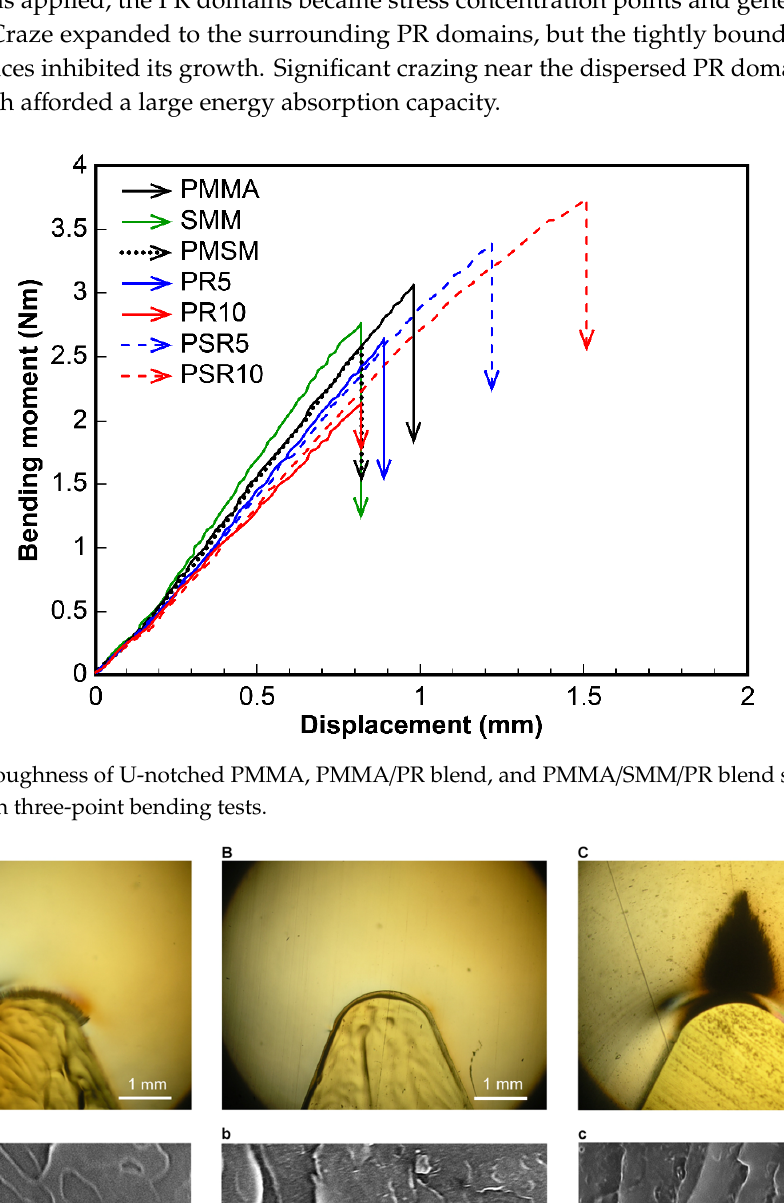
Figure 9. Polarized light micrographs of ( A ) PMMA, ( B ) PR10, and ( C ) PSR10. SEM images of ( a ) PMMA, ( b ) PR10, and ( c ) PSR10 in regions of plastic deformation at the notch tips.